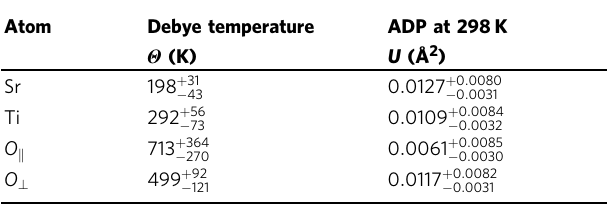
Table 1 Re fi ned atomic displacement parameters for cubic SrTiO 3